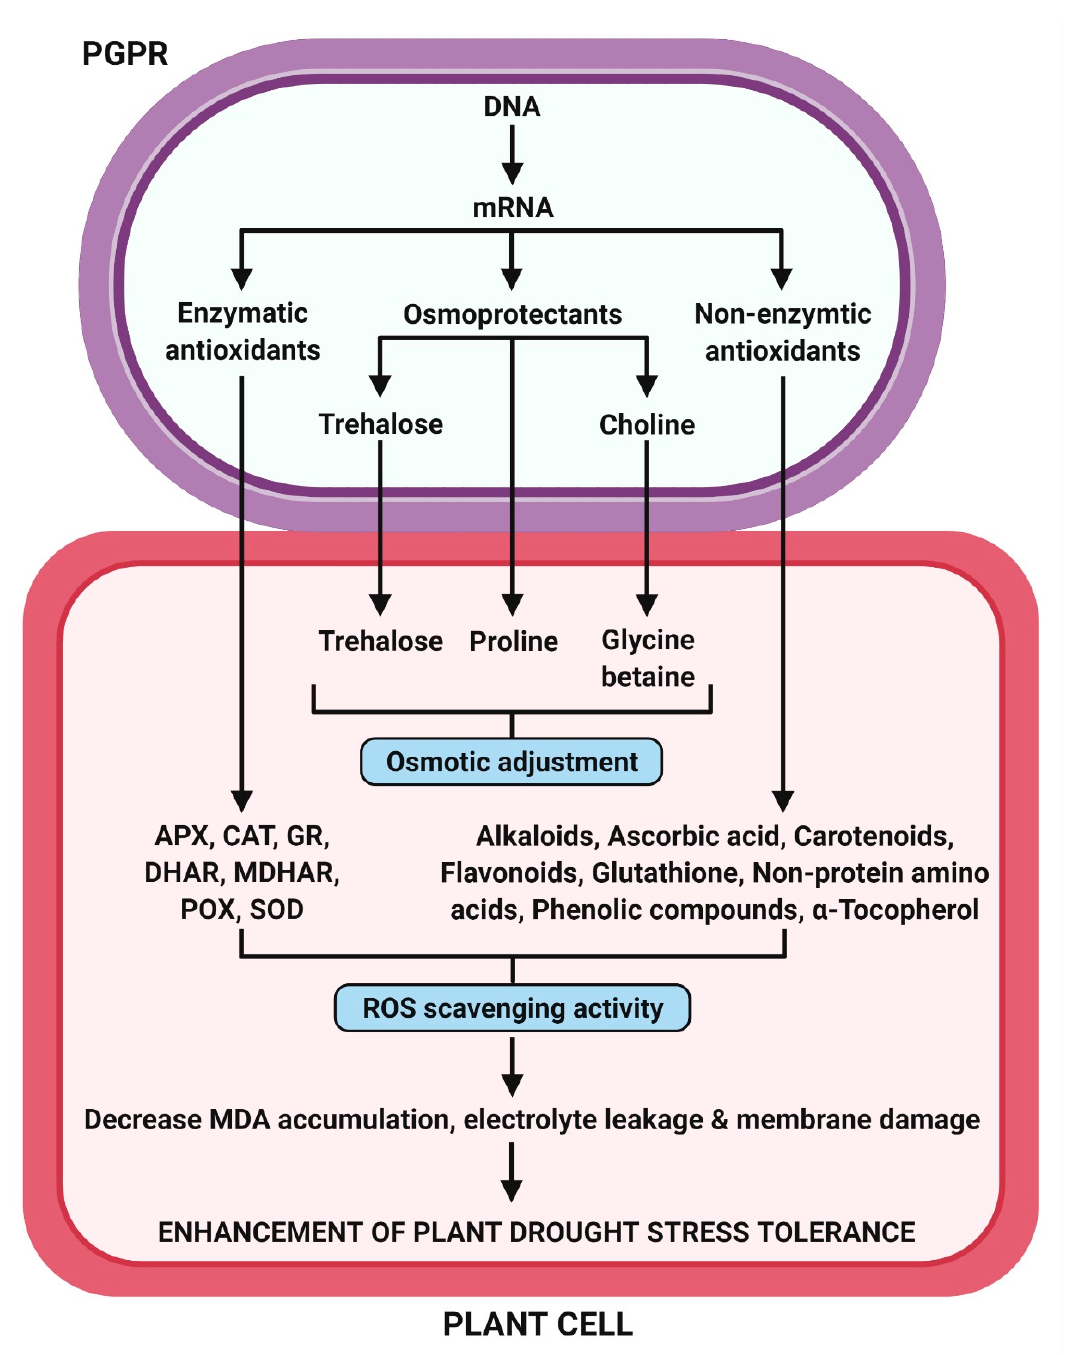
Figure 5. PGPR-mediated induced antioxidant defense system for the drought stress tolerance in plants.